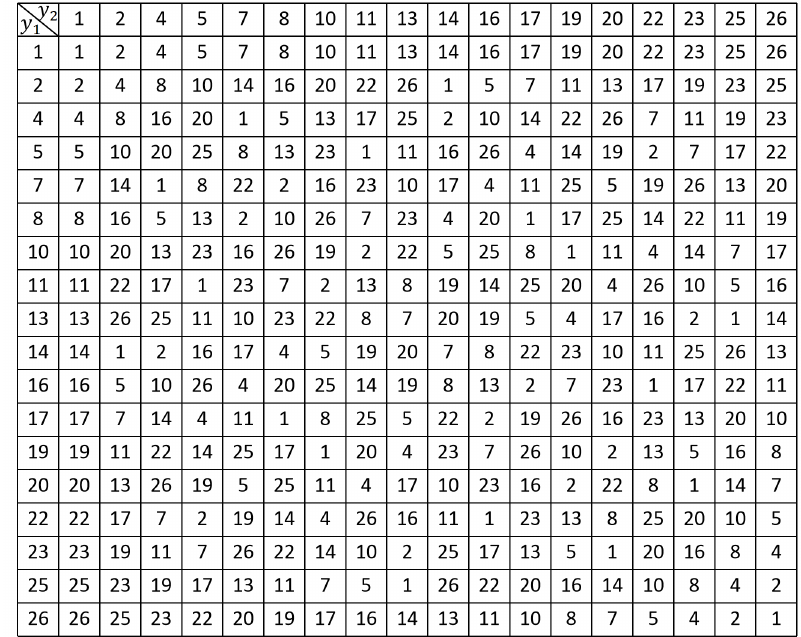
Table 6. p = 3 , m = 2 case: the multiplication of y 1 , y 2 ∈ Y